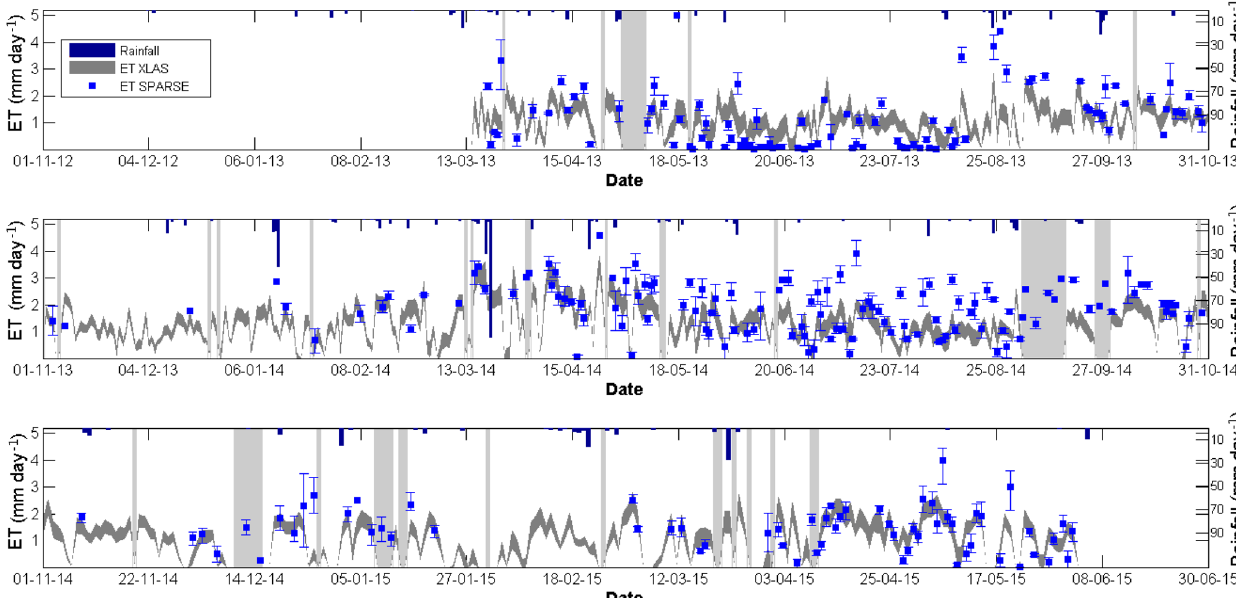
Figure 11. Modeled vs. observed daily latent heat fluxes. Dark grey color shows minimum and maximum daily observed LE. Light grey vertical bars show gaps in XLAS data. Error bars for the modeled ET show the minimum and the maximum daily ET resulting from the three methods used to compute daily ET from instantaneous modeled